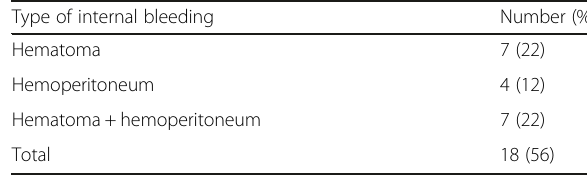
Table 2 Distribution of patients according to the type of hemorrhage indicated by ultrasonography (percentages exceed 100 % because the same patient can have